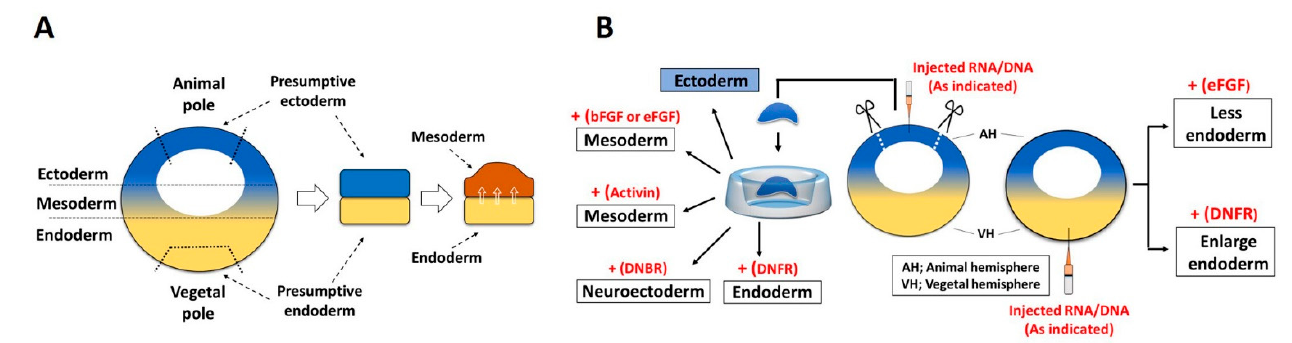
Figure 3. Outline of key experiments in embryonic induction. ( A ) a conjugation assay for vegetal explant and ectodermal explant. ( B ) The embryos are injected with RNA/DNA of various genes (indicated in red text) and the dissected explants are then cultured. Upon injection of an inducer, the explants then differentiate into various embryonic germ layers (indicated in boxed text). The majority of experiments are performed with Xenopus embryos.